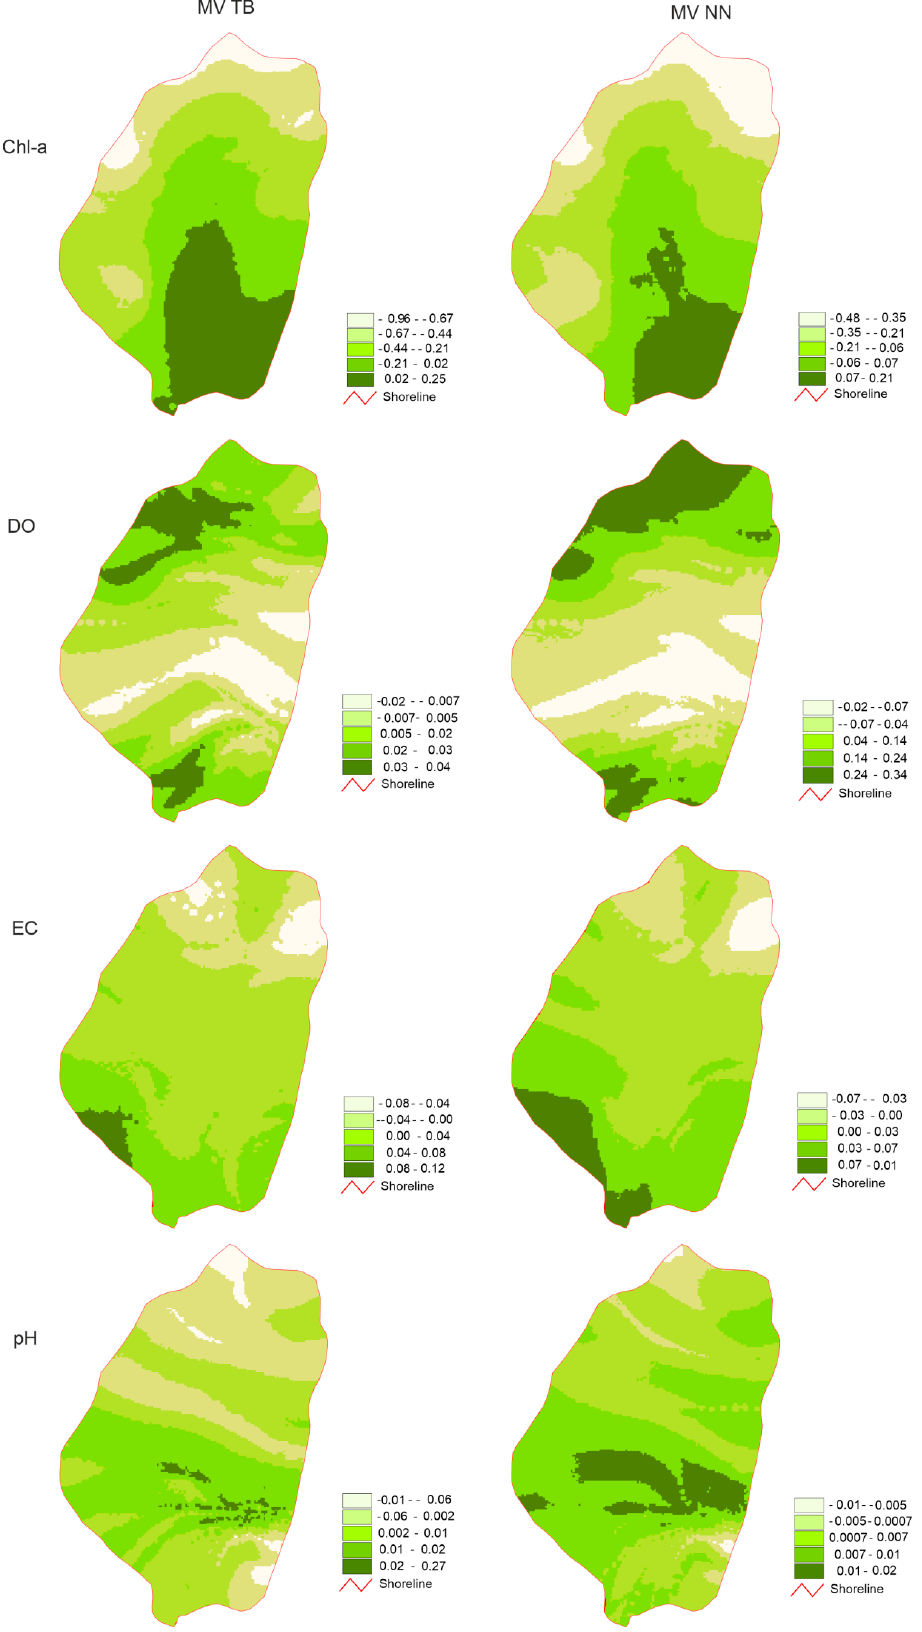
Figure 3. Maps of mean values (MV) for both TB (1) and NN (2)